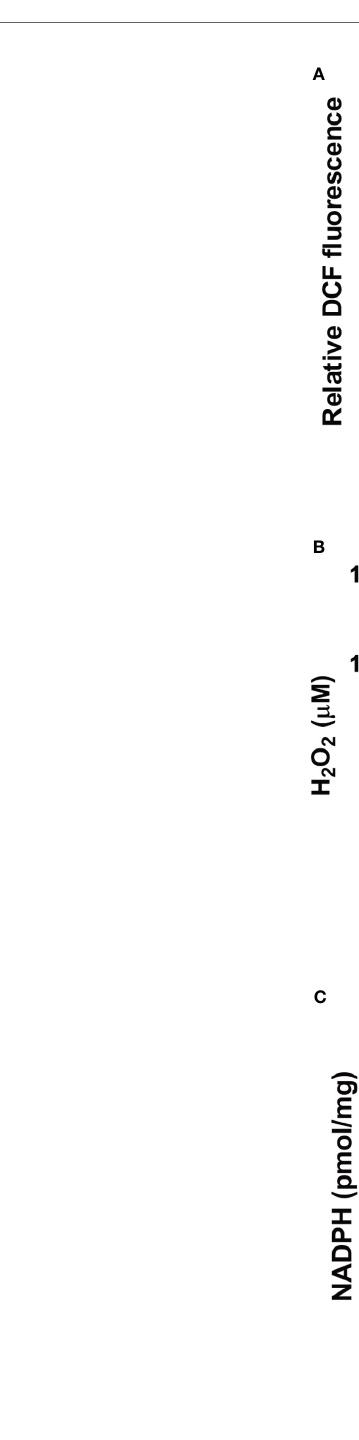
FIGURE 7 | E. bovis infection boosts intracellular ROS production in the host cell. To evaluate the redox status in E. bovis – infected cells over time, intra- and extracellular ROS production and intracellular NADPH concentration were evaluated. (A) Intracellular ROS production was evaluated E. bovis – infected ( ◌ ) and non- infected cells ( (cid:129) ) loaded with DCFH-DA. Fluorescence intensity was measured and the results were plotted as relative fl uorescence units. (B) Supernatants from non- infected and E. bovis – infected BUVEC were collected between 5 and 24 days p. i. and H 2 O 2 concentration was determined by Amplex Red-based tests. (C) The same monolayers used for the supernatant measurements, were collected and used to quantify intracellular NADPH concentrations. Statistical analysis applied was a two-way ANOVA with repeated measurements de fi ning the time as the matching variable (signi fi cance de fi ned as a ≤ 0.05). Values are expressed as means ± SD of three biological replicates. *p = 0.05, **** p ≤